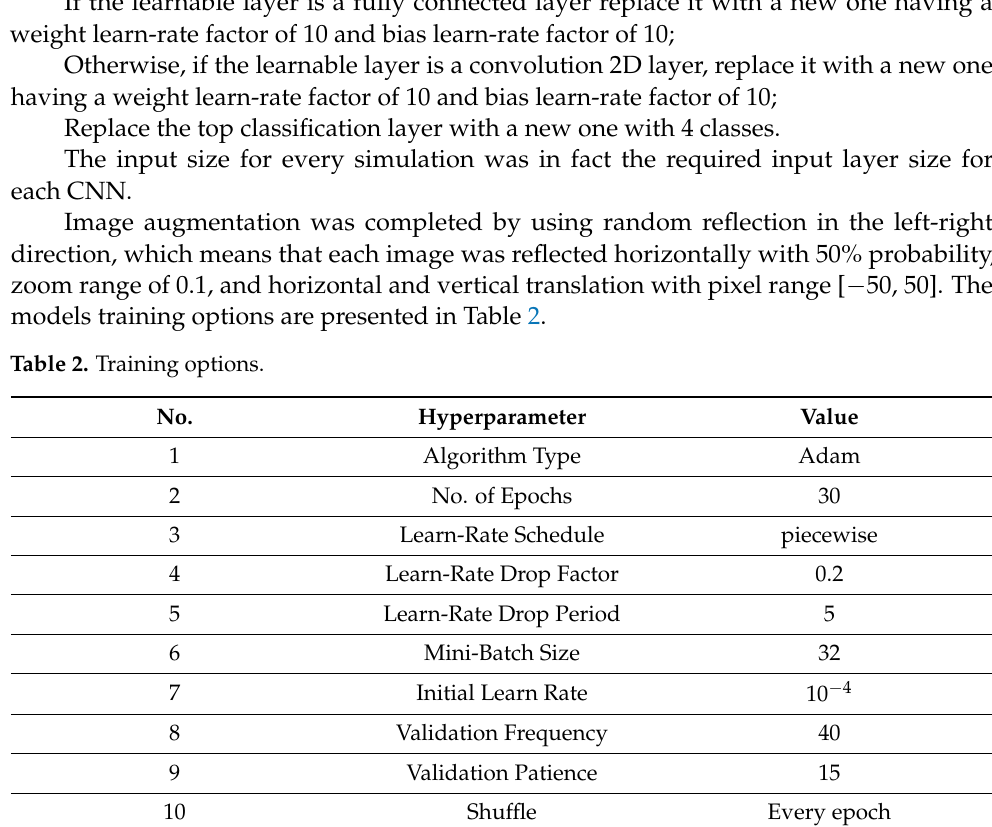
Table 3. The dataset distribution into classes.